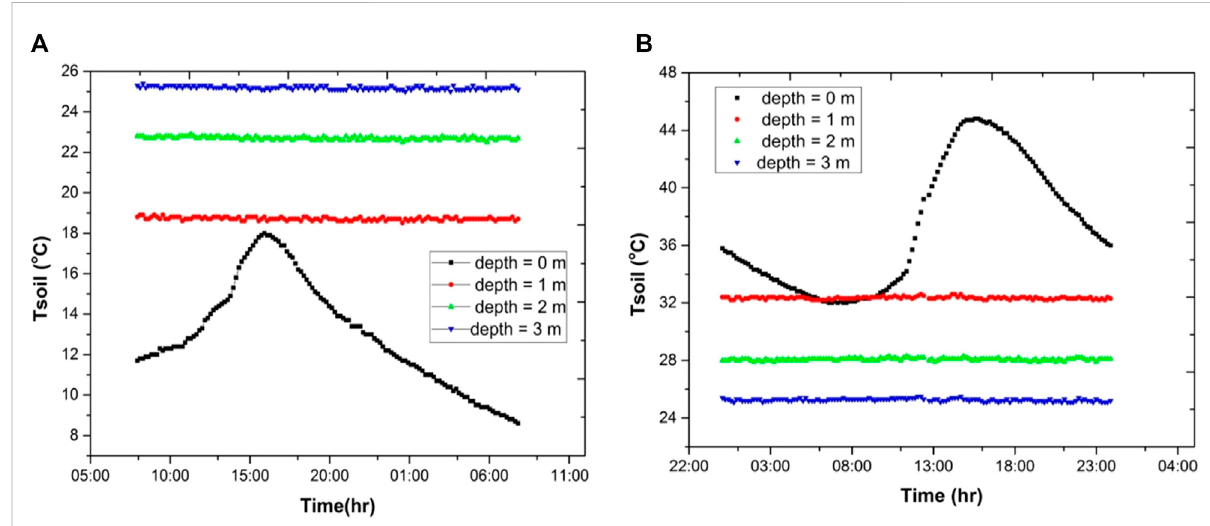
FIGURE 6 The daily variation of soil temperature with time during (A) January and (B)